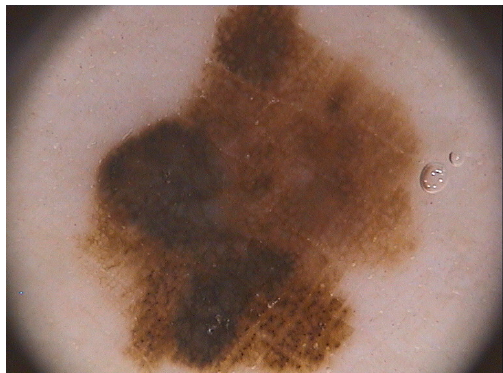
Figure 1. Image of a melanoma taken from a publicly available database. Melanoma is a